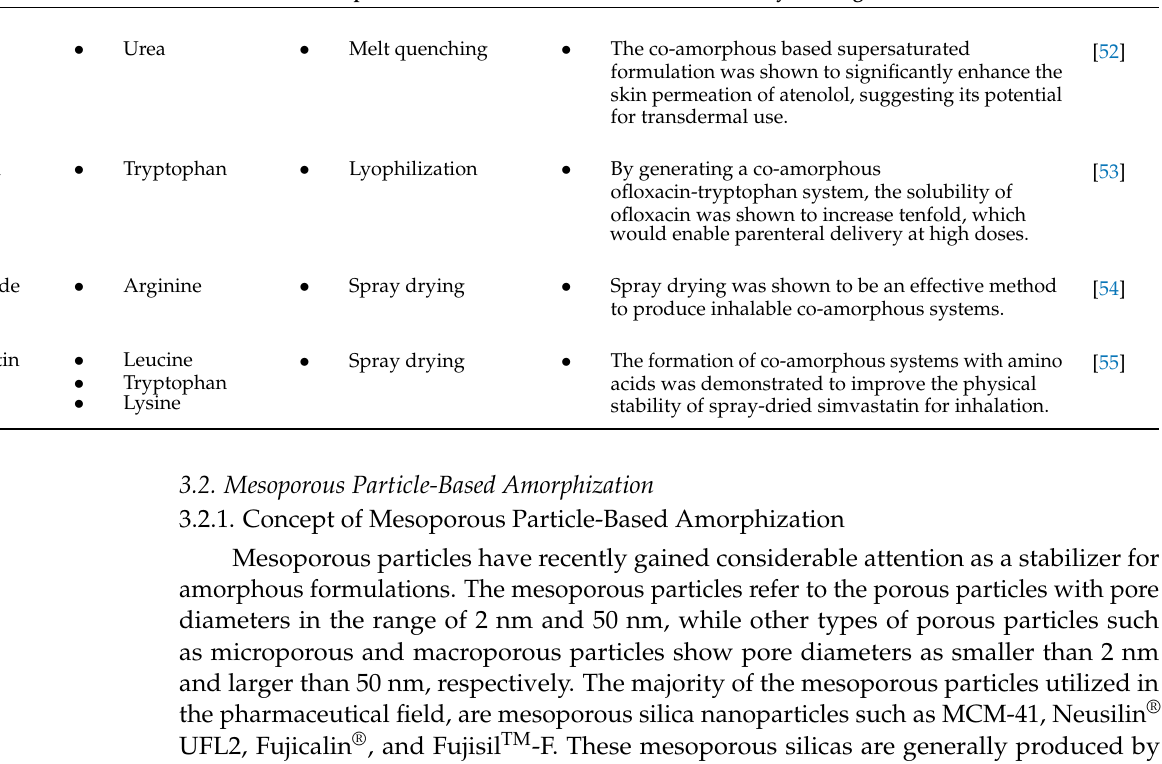
Table 4. Recent examples of co-amorphous systems applicable for different routes of administration. Drug. Carrier Preparation Method Key Findings